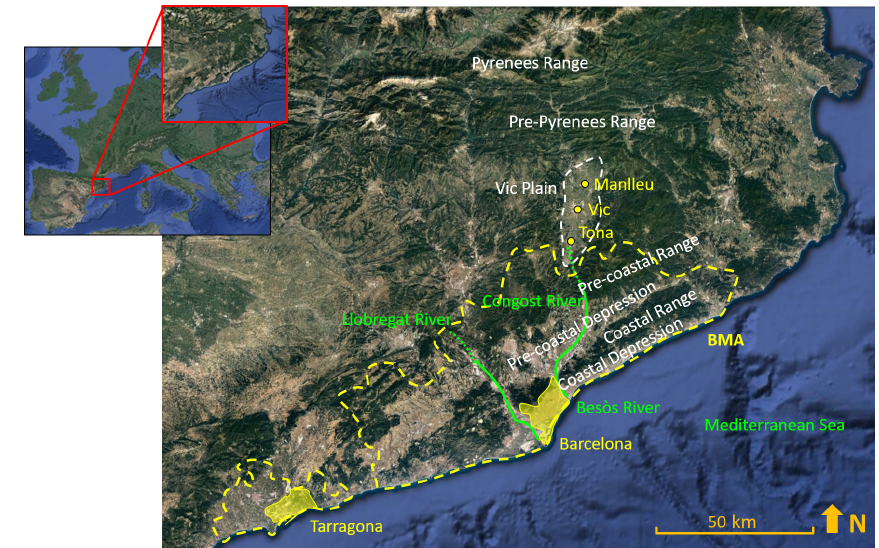
Figure 1. Location and main topographic features of the area of